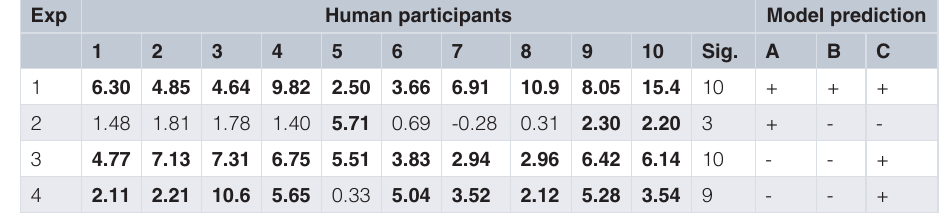
Table 1. Statistics of the aftereffect. Represented in the table are the aftereffect z scores calculated for each participant for the 4 experiments (Exp). The bolded numbers are the ones considered significant under the assumption of α =0.05 ( | z | > 1.96). The significant column (Sig.) in the table represents the number of z scores (out of 10) that are significant in that experiment. The table also includes results from the three models: + indicates a presence of aftereffects prediction and – indicates an absence of aftereffects